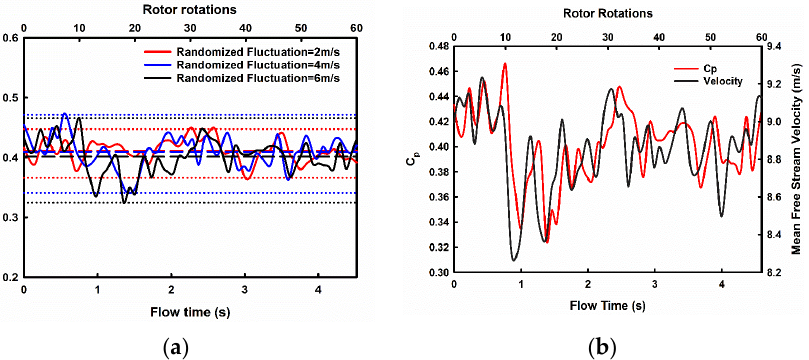
0.01 from the randomised fluctuation of 6 m/s to 2 m/s is due to the same reason. The mean C p values of cases with randomised inlet velocity are always higher than uniform velocity cases due to the effect of upstream macro-turbulence. The mean C p value for randomisa- tion fluctuation of 2 m/s is 0.411 and mean C p for uniform velocity is 0.400 for λ = 4.1.